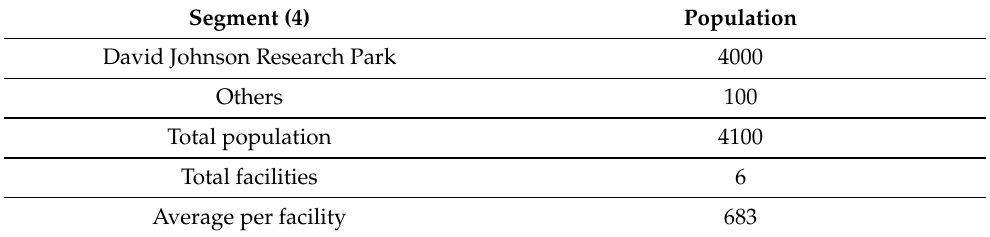
Table 6. Descriptive Statistics for Research Parking Buildings.